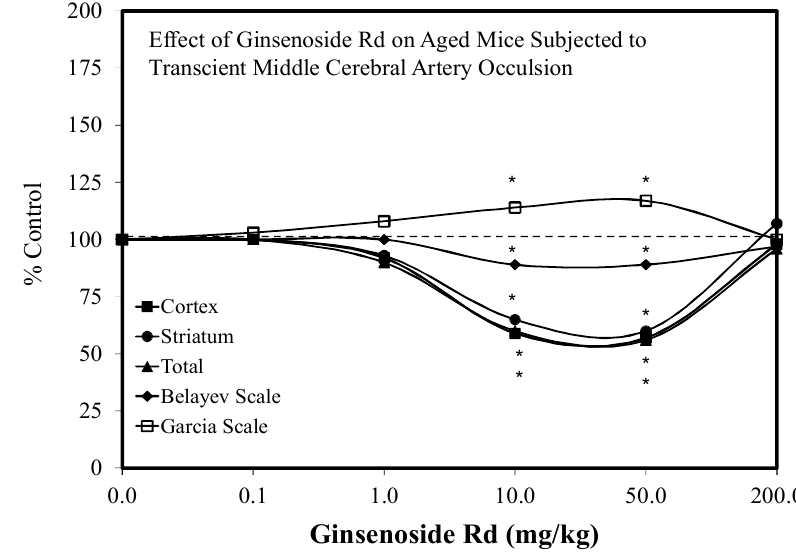
Figure 24. Effects of ginsenoside Rd on LDH release in H2O2-induced cytotoxicity with PC12 cells (source: [102]). Each * represent statistical significance for a data point.